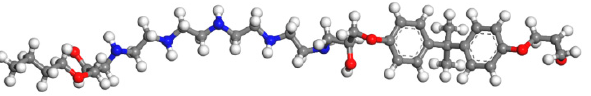
Figure 8. The model of epoxy resin cured with TEPA (colour legend: hydrogen H (white); oxygen O (red); carbon C (grey); nitrogen N (blue)).